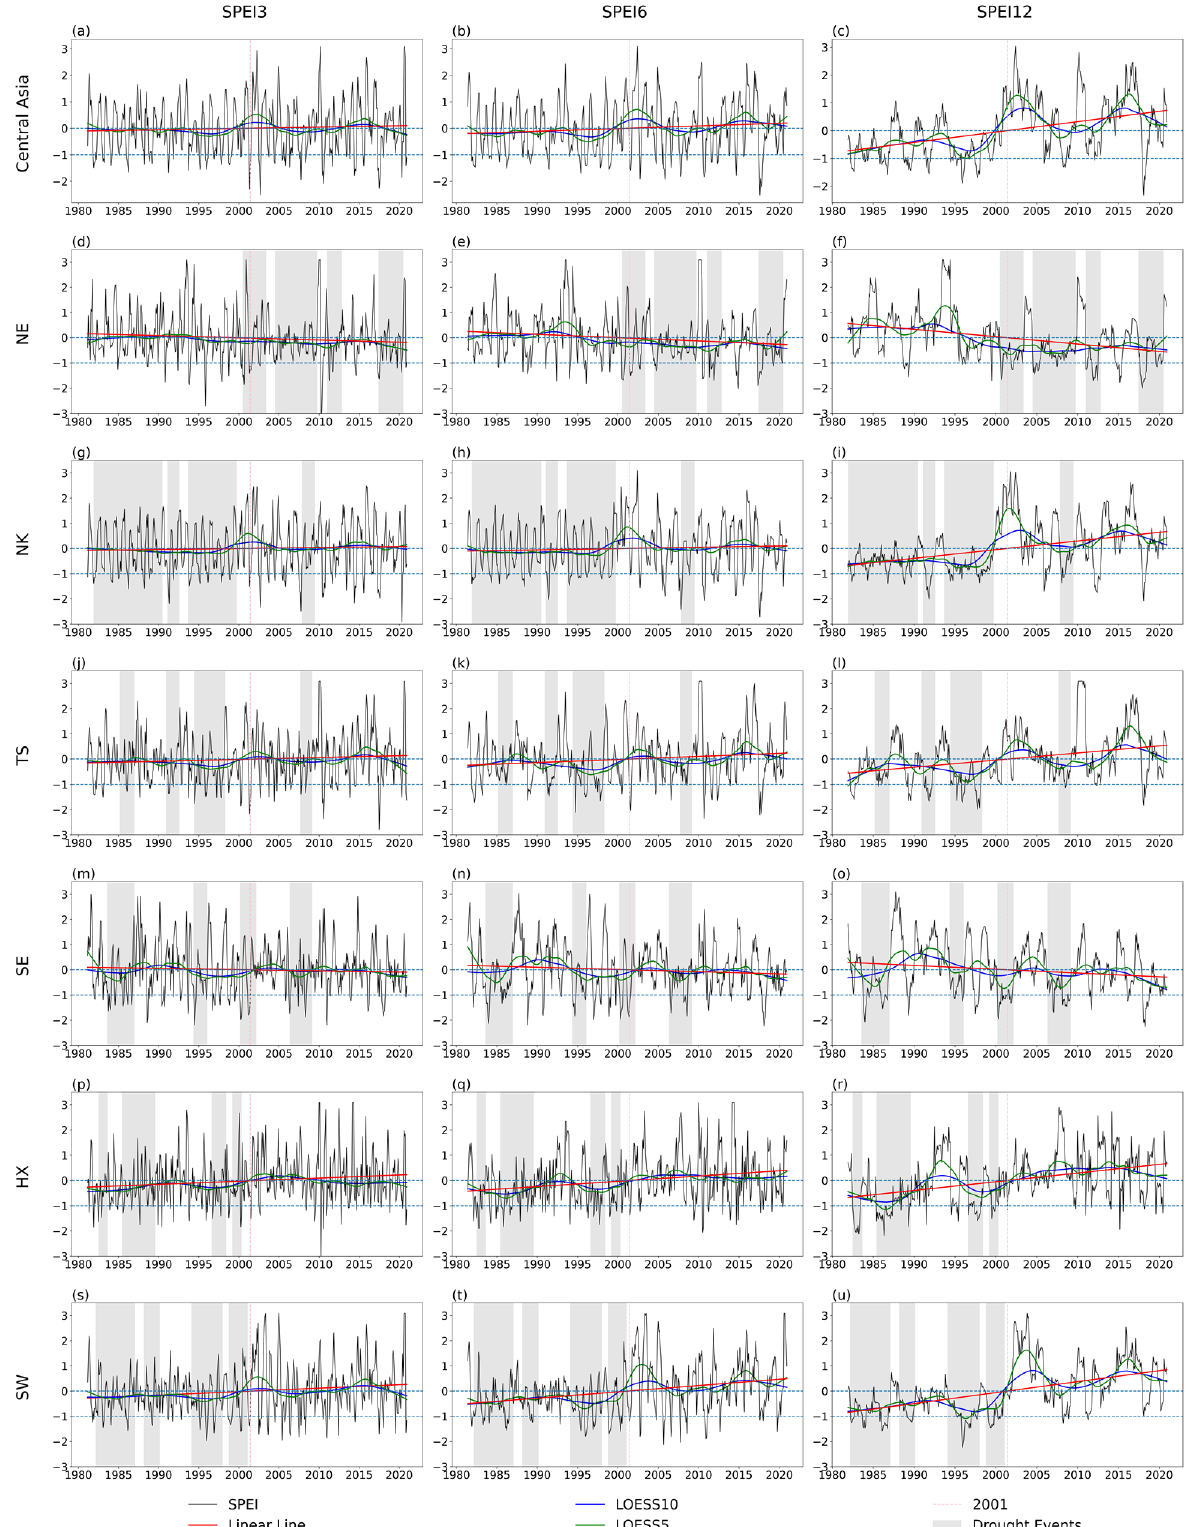
Figure 7. Temporal evolution of drought for the values of SPEI3, SPEI6, and SPEI12 in Central Asia and six subregions. Subplots ( a – u ) represent the drought trend in Central Asia and six subregions at different time scales (SPEI3, SPEI6,and SPEI12).